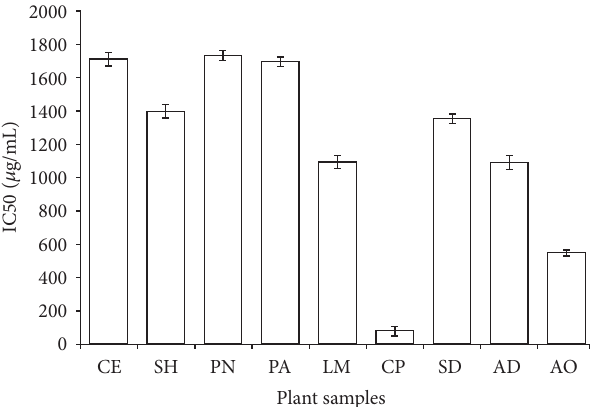
Figure 4: ABTS free radical scavenging activity of methanol crude extracts from selected antidiabetic plants used in southeast Nigeria. CE, Chlorophora excelsa ; CP, Ceiba pentandra ; SH, Strophanthus hispidus ; SD, Synsepalum dulcificum ; PN, Picralima nitida ; AD, Anthocleista djalonensis ; PA, Persea americana ; AO, Anacardium occidentale; LM, Loranthus micranthus . Results are expressed as mean ± SD ( 𝑛 = 4